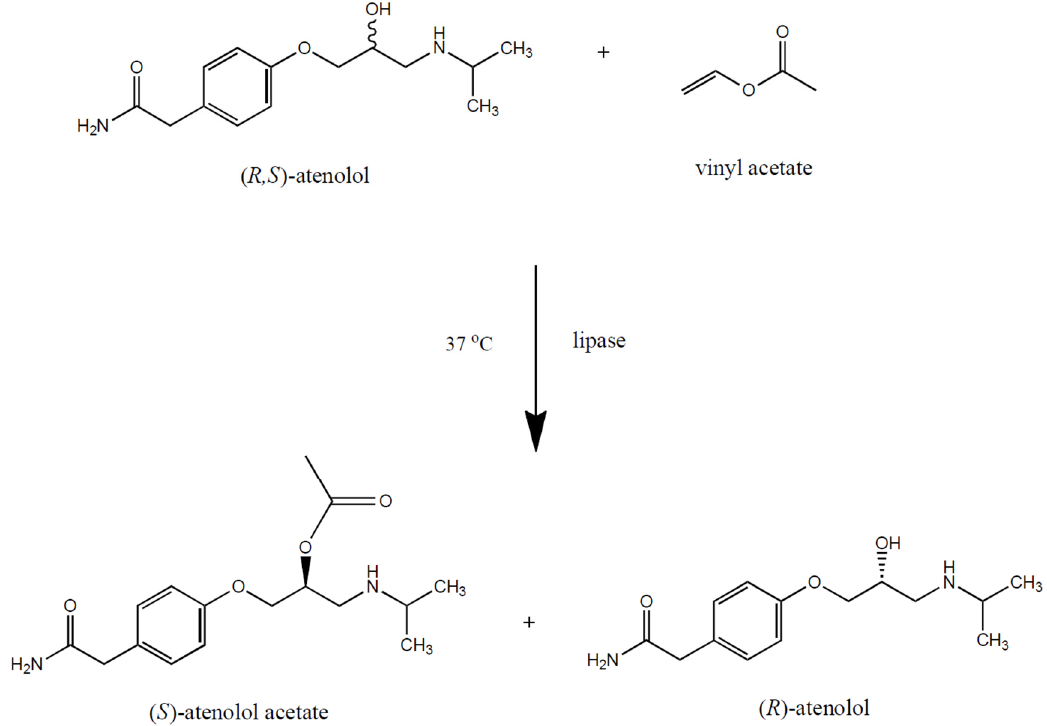
Figure 1. Enantioselective biotransformation of ( R , S )-atenolol with the use of Candida rugosa lipase as biocatalyst. The reaction mixture consisted of ( R , S )-atenolol (3.0 mg, 0.01 mM), vinyl acetate (2.0 µL, 0.02 mM), lipases from Candida rugosa OF or MY (10.0 mg), and toluene (10 mL) with or without the addition of ionic liquid (500 µL) and was incubated for 120 h along with mechanical shaking (250 RPM) at 37 °C. Table 1. List of obtained results of performed enantioselective biotransformation of (R,S)-atenolol after 120 h of incubation: enantiomeric excesses of substrates ( ee s ), products ( ee p ), conversion ( c ), and enantioselectivity ( E ).